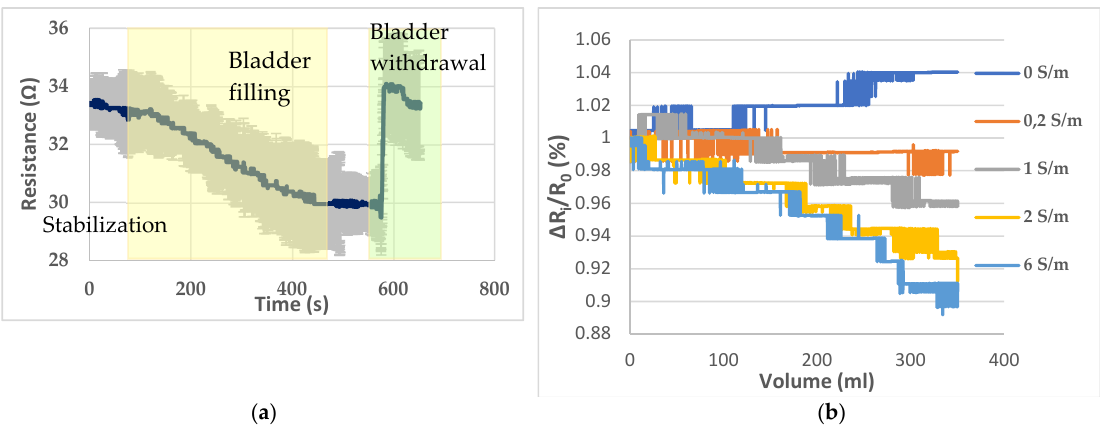
Figure 7. ( a ) Bladder filling and withdrawal recording; ( b ) resistance variations recorded with the different solutions presented by Table 2.